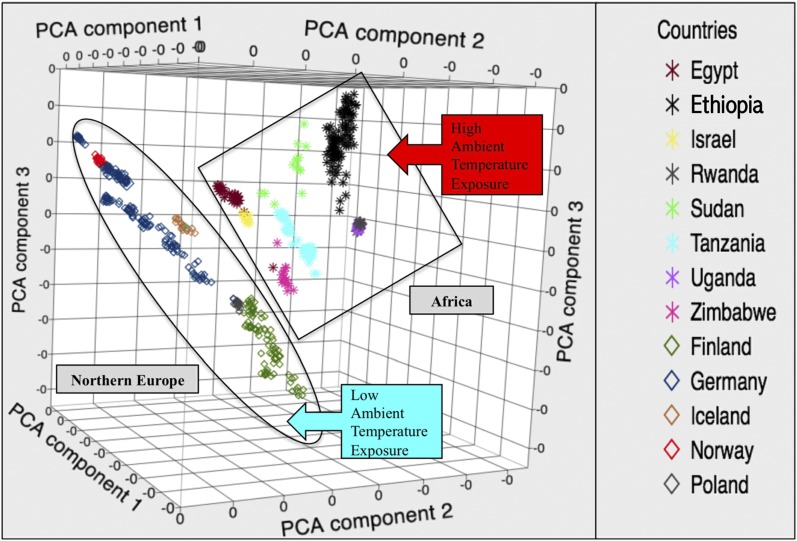
Plot shows that the genotypes and 30-yr temperature profiles for each sampled country differentiated the chickens into their indigenous countries. This differentiation indicates that divergence between the breeds is partly due to environment and that the breeds can be grouped by environment (i.e., higher ambient temperatures and lower ambient temperatures). The oval surrounds the cluster of Northern European countries and the square represents the African countries. PCA, principal component analysis.